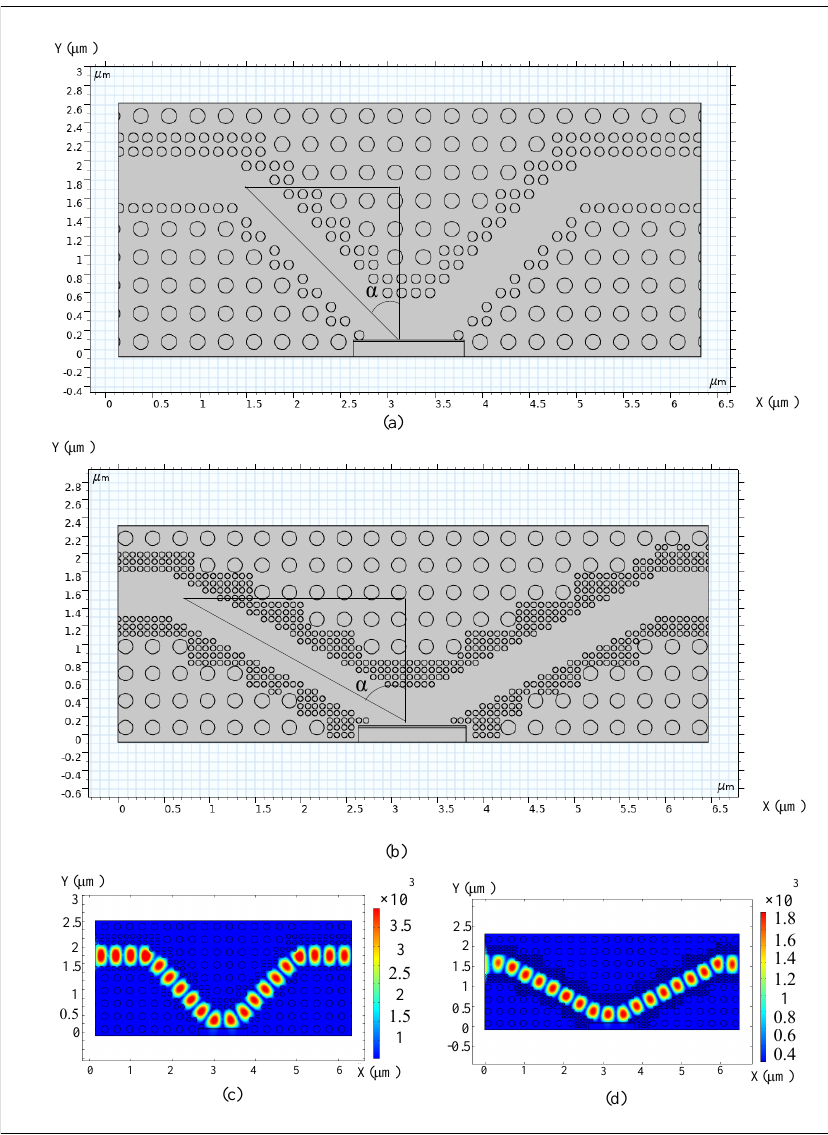
Figure 6. ( a , b ) The optical sections of ERMs based on hybrid PhC structures are shown with deflection angles of 45 and 60 degrees. ( c ) The electric field propagation plot for TE polarization in the PhC waveguide section corresponding to part ( a ). ( d ) The electric field propagation plot for TE polarization in the PhC waveguide section corresponding to part ( b